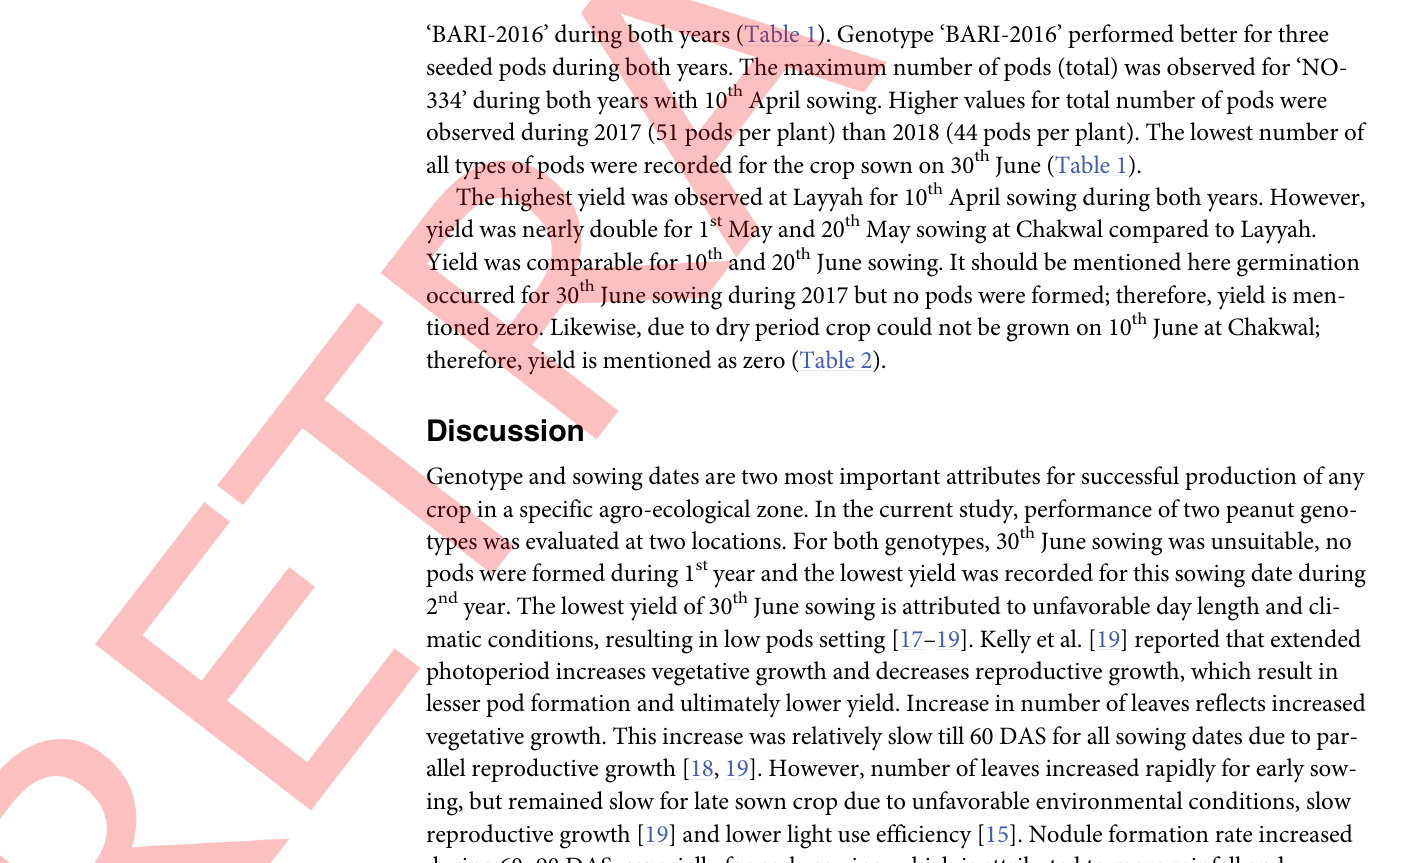
Fig 3. Effect of sowing date and genotype on A) root dry biomass (g) per plant and B) increase in root dry biomass (g) per plant per day. Each value is average of two years and three replications (n = 6).